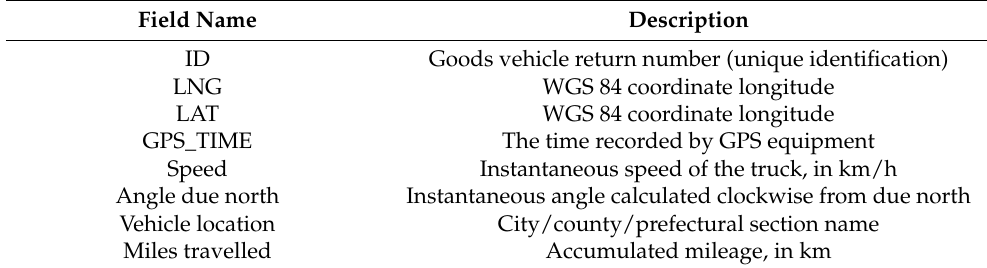
Table 1. Structure of the truck trajectory data.